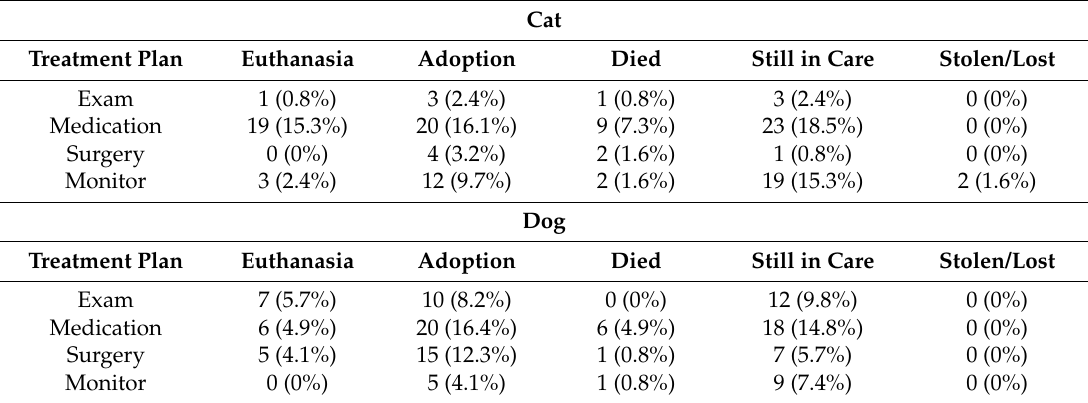
Table 5. Summary of actual numbers ( n = 124 cats and 122 dogs) and percent of total sample of treatment plan.